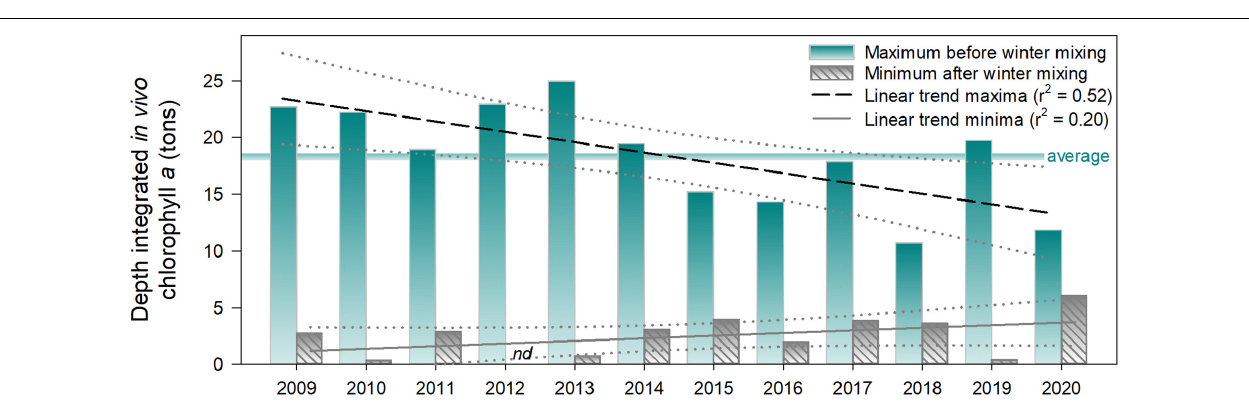
FIGURE 4 | Annual maximal and minimal values of depth-integrated P. rubescens in vivo chlorophyll a (tons) in Lake Zurich from 2009 to 2020. Trends are shown as linear regressions. Years refer to the time of vernal deep mixing and the subsequent population minimum. Maxima refer to the highest population value between two minima. Maximal values were occasionally reached shortly before deep water mixing of the following year (see high-resolution dynamics in Figure 3A ). In 2012, the vernal minimum was at the limit of detection of the bbe FluoroProbe (indicated by nd ). The horizontal line indicates the average of maxima (18.4 tons) during all the years of